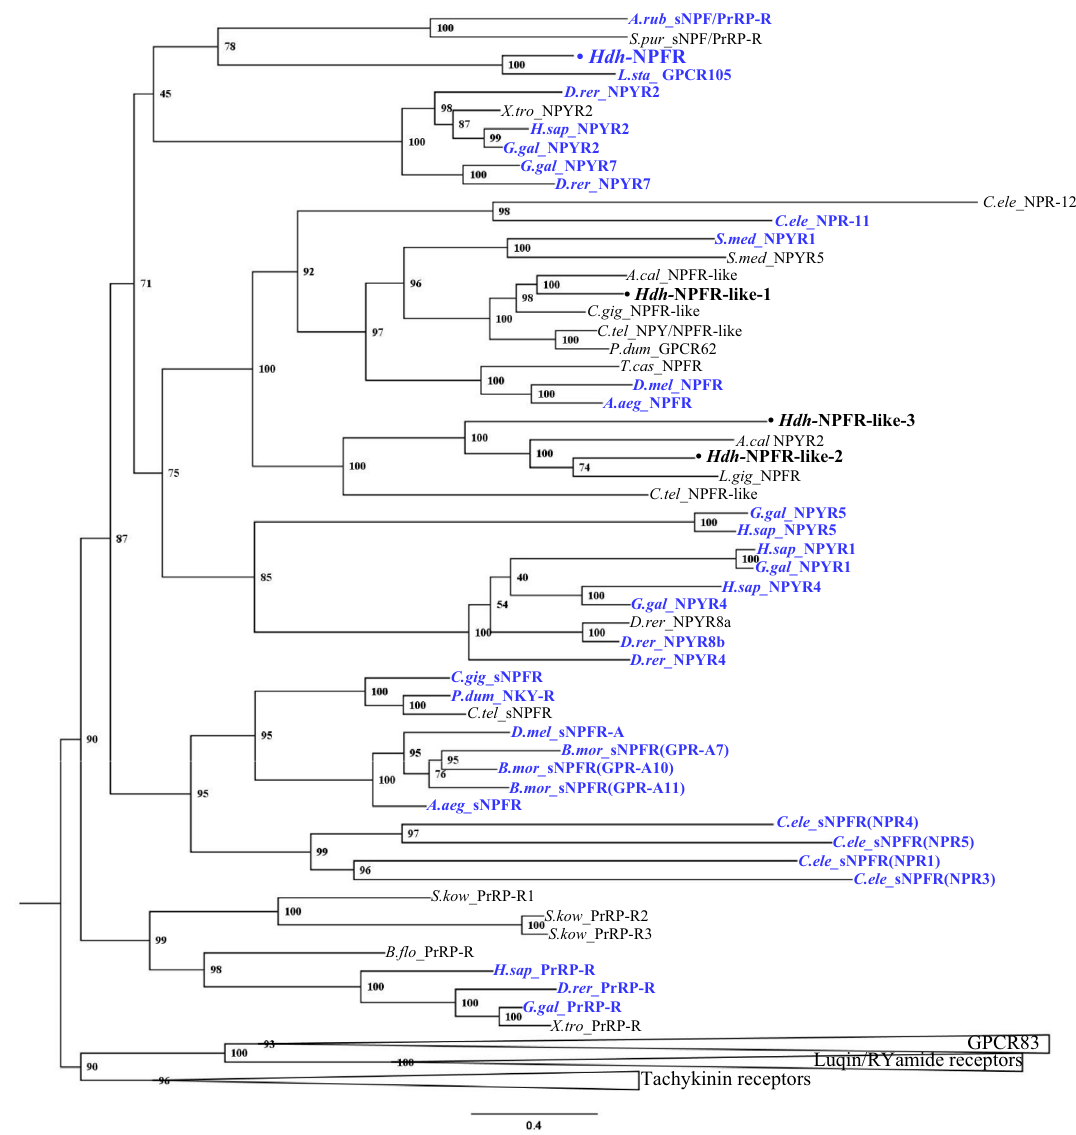
Figure 2. Phylogenetic tree analysis of Hdh-NPFR and three Hdh-NPFR-like receptors with bilaterian NPY/ NPF-type, protostome sNPF-type, and deuterostome PrRP-type receptors. Luqin/RYamide-type, tachykinin- type, and GPCR83-type receptors were used as outgroups (condensed). Amino acid sequences of the receptors (Supplementary Table S2) were aligned and trimmed 270 residues were used to generate the maximum likelihood tree using W-IQ server. Ultrafast bootstrap values are given at each branch, and scale bar indicates amino acid substitutions per site. Deorphanized receptors for which receptor-ligand interactions have been experimentally characterized are colored in